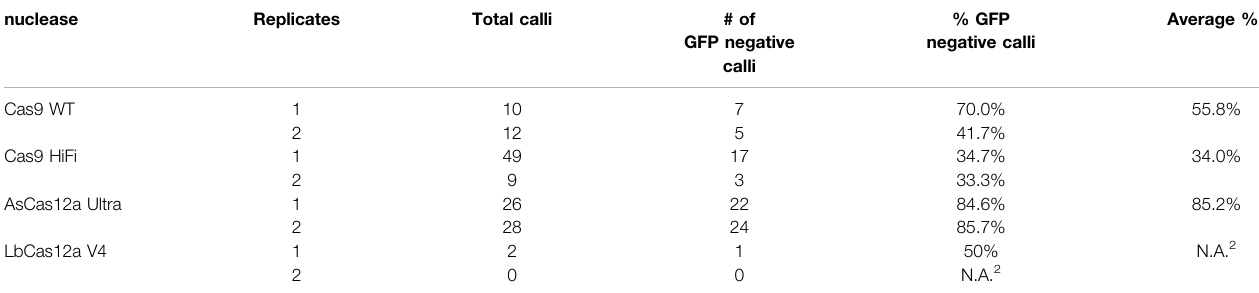
TABLE 1 | Assessment of mutagenesis frequencies in regenerated calli (E0). nuclease